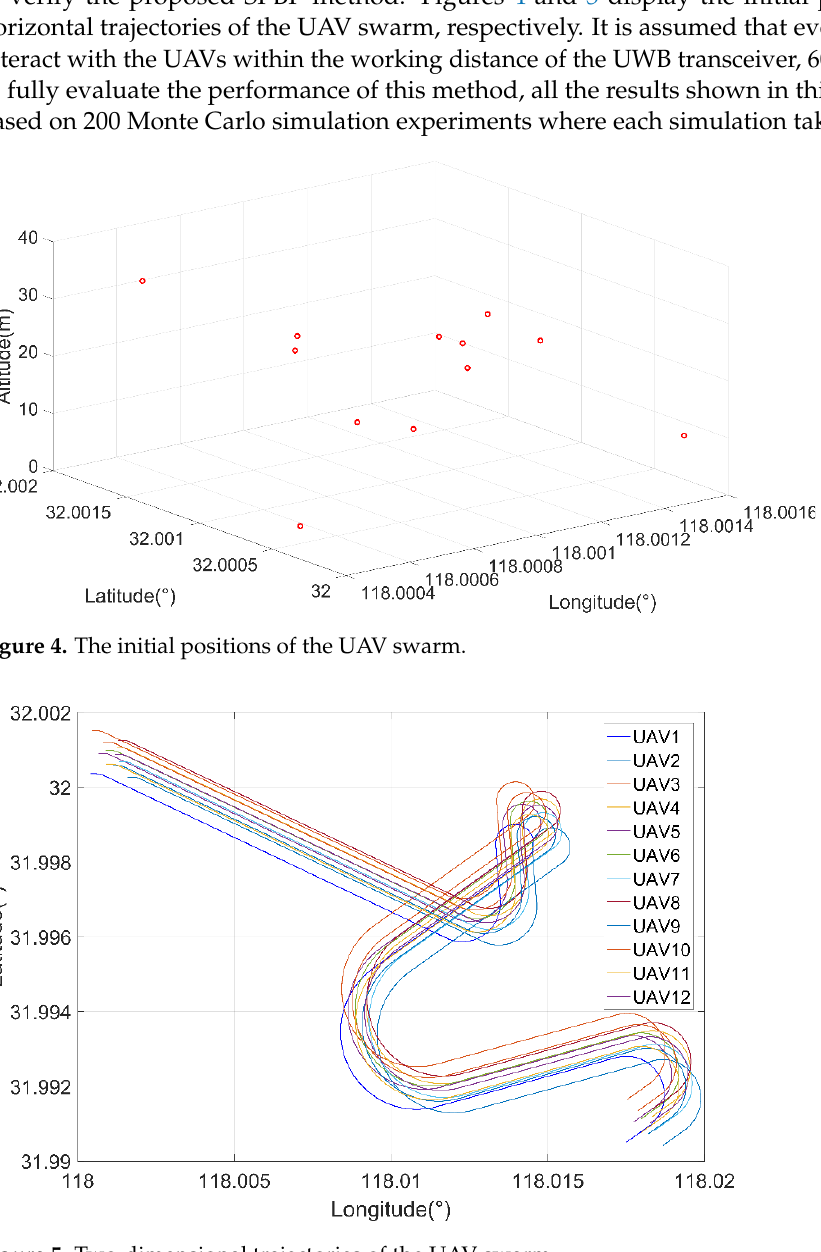
Figure 5. Two-dimensional trajectories of the UAV swarm.